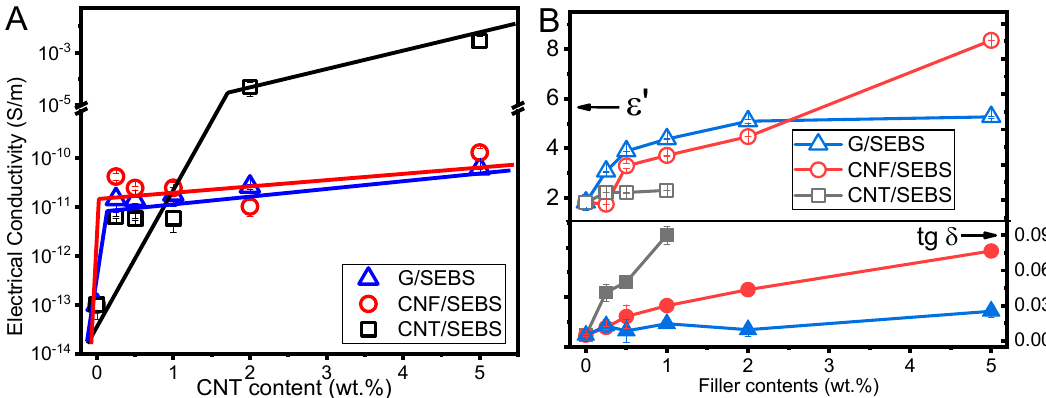
Figure 6. ( A ) Electrical properties of the SEBS and composites with G, CNF, and CNT. The lines are for guiding the eyes; ( B ) Dielectric constant and losses for SEBS composites with different nanofillers at 1 kHz.